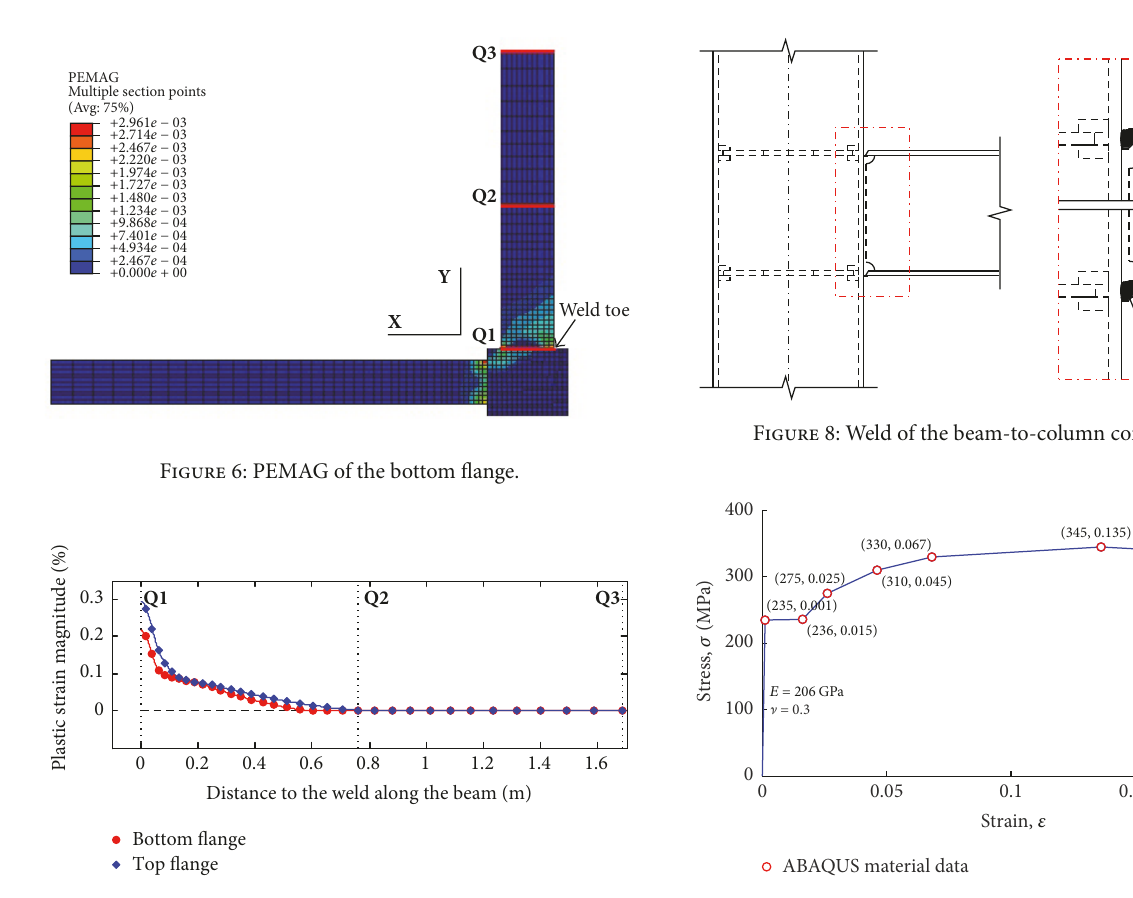
Figure 9: Constitutive model of Q235B